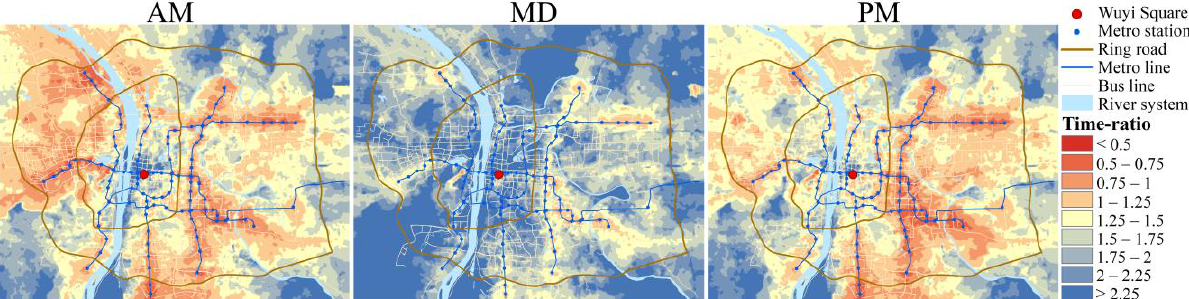
Figure 3. Time-ratio distribution for the three time periods.